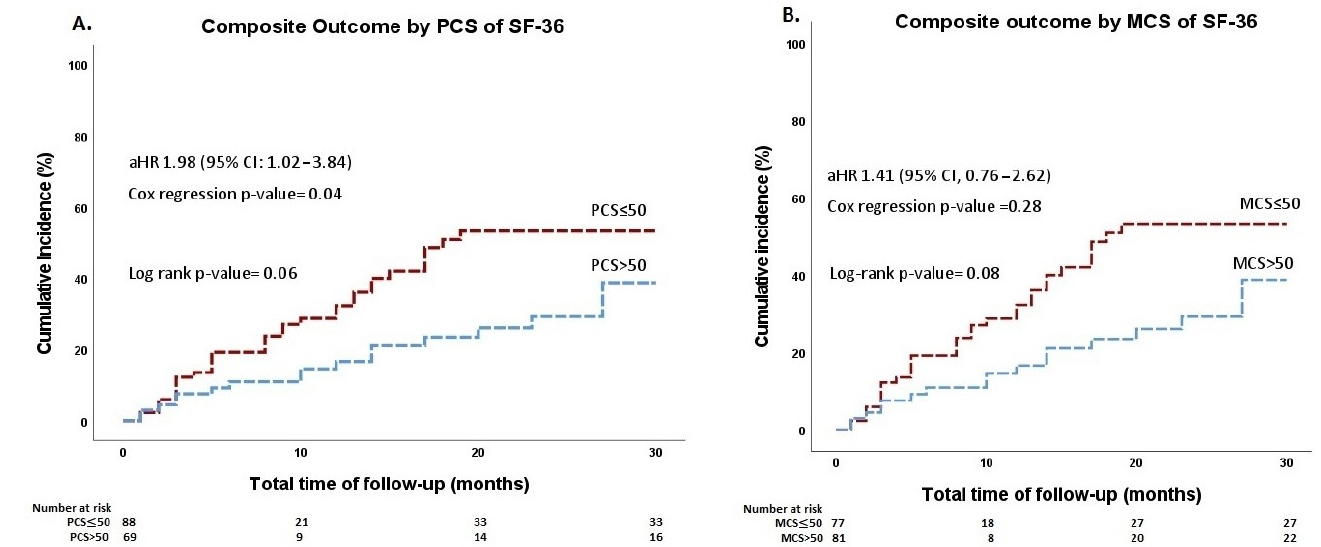
Figure 1. Cumulative incidence curves of the composite outcome stratified by ( A ) the physical component summary of the SF-36 and ( B ) the mental component summary of the SF-36 Health Survey. MCS, mental component summary; PCS, physical component summary; SF-36, 36-Item Short Form.